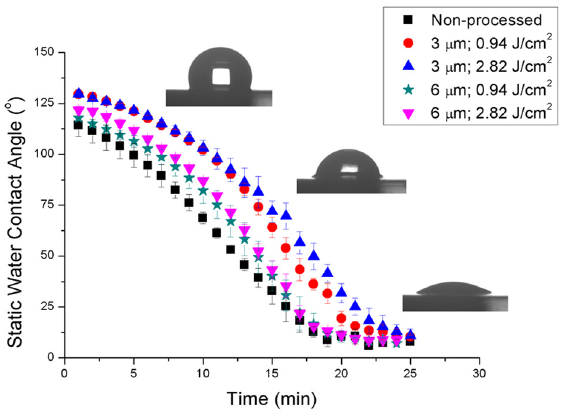
Figure 6. Time-dependent static water contact angle measurements performed during the absorption of the water droplet by the polymer samples.